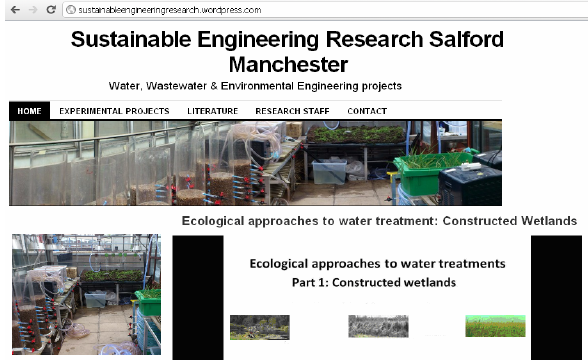
Figure 2. E-Learning environment of weblog screen